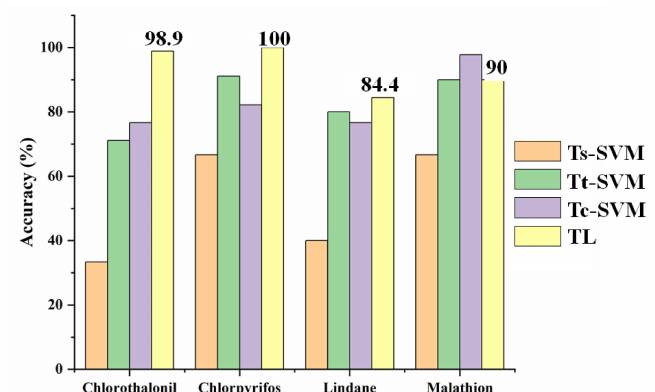
Figure 10. Accuracy comparison of the different methods. Ts-SVM and Tt-SVM represented SVM models trained by 120 samples from the source domain and 30 samples from the target domain, respectively; Tc-SVM represented the SVM model trained by the combination of Ts and Tt; TL represented the TrAdaBoost model based on SVM. The test samples for these methods were the remaining target domain